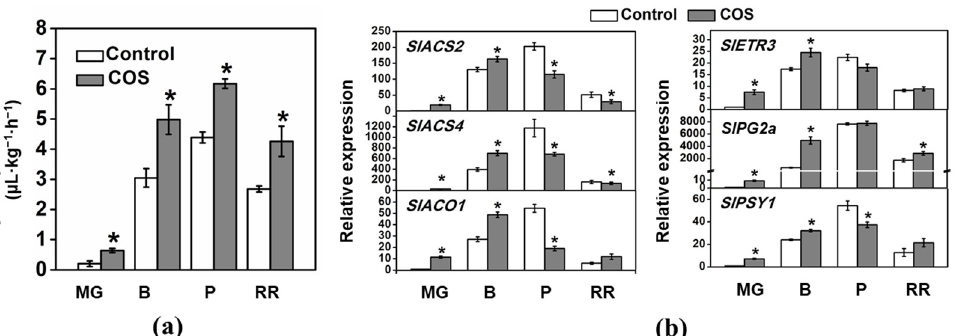
Figure 4. Effect of COS on ethylene production and signaling in tomato fruits. ( a ) Ethylene production in COS-treated and control fruits. ( b ) Expression levels of genes involved in ethylene biosynthesis, perception, and response in COS-treated and control fruits. Data represent the means ± SD of three biological replicates. Asterisks represent a significant difference compared with the control based on Student’s t ‐ test (* p < 0.05). MG: mature green; B: breaker; P: pink; RR: red ripened.